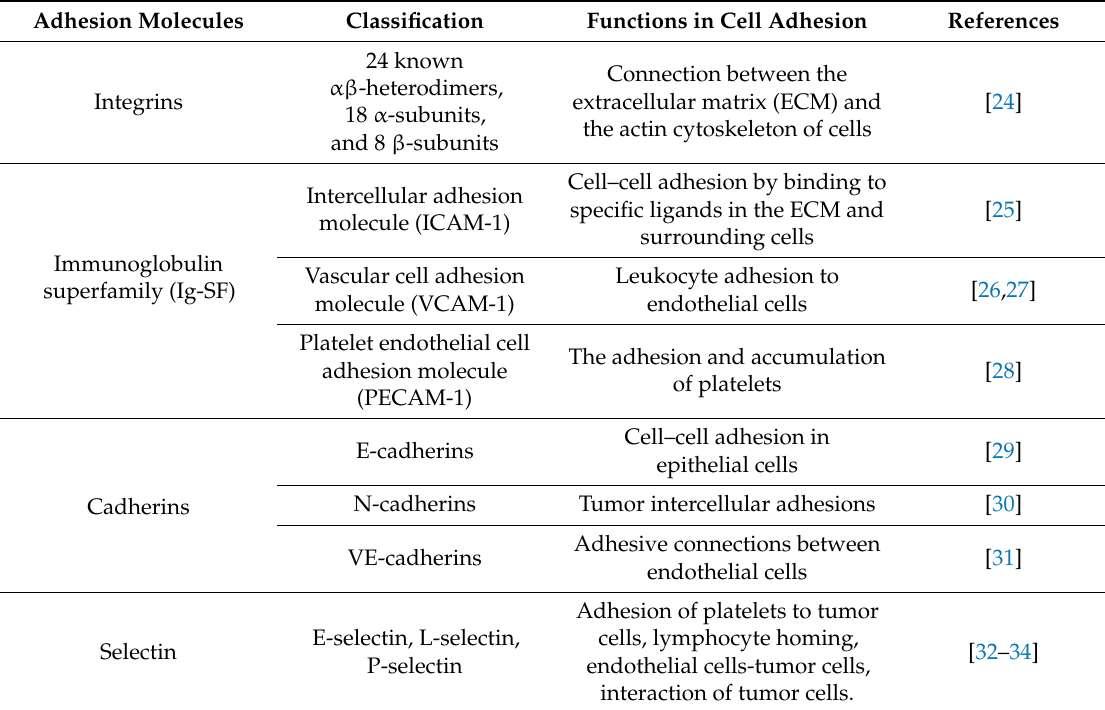
Table 1. The summary of cell adhesion